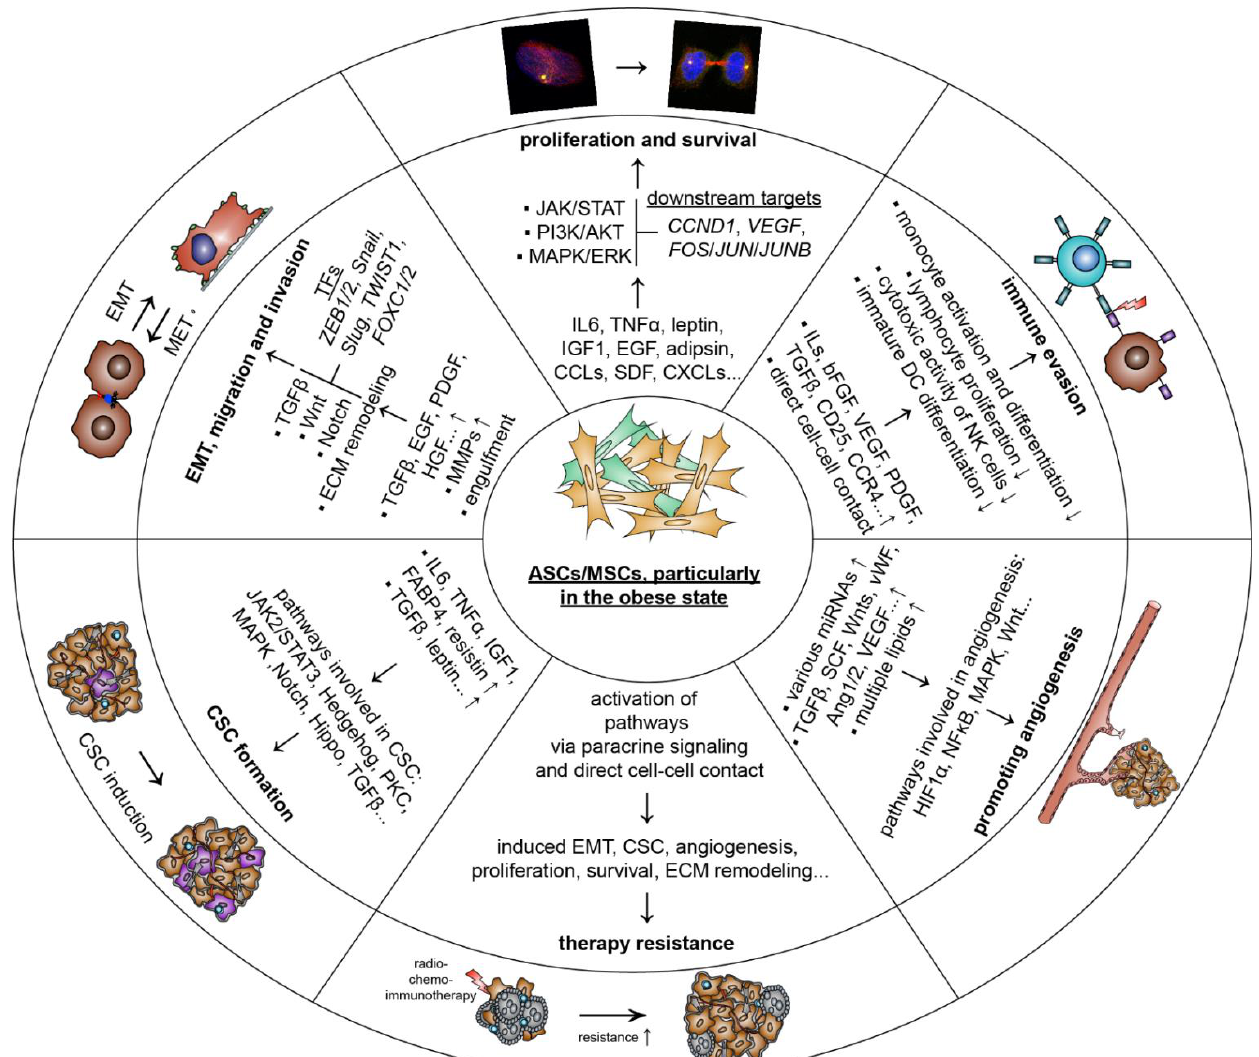
Figure 2. Schematic representation of potential effect of ASCs/MSCs on breast cancer cells and related molecular mechanisms. ASCs/MSCs may promote breast cancer cell proliferation and survival, EMT, migration, and invasion; CSC formation; angiogenesis; immune evasion; and therapy resistance. ASCs, adipose-tissue-derived mesenchymal stromal/stem cells; MSCs, mesenchymal stromal/stem cells; IL6, interleukin 6; EMT, epithelial-to-mesenchymal transition; STAT3, signal transducer and activator of transcription 3; ERK, extracellular-signal regulated kinase; IGF1, insulin-like growth factor 1; VEGF, vascular endothelial growth factor; MAPK, mitogen-activated protein kinase; AKT, protein kinase B; CCL2, monocyte chemotactic and activating factor; EGF, epithelial growth factor; PDGF-D, platelet-derived growth factor D; Wnt, wingless/integrated; TGF β , transforming growth factor β ; PI3K, phosphoinositide 3-kinase; CCR4, C-C motif chemokine receptor 4; TNF α , tumor necrosis factor α ; CD25, cluster of differentiation 25; SNAI, snail family transcriptional repressor; ZEB1, zinc finger E-box binding homebox 1; CAF, cancer-associated fibroblast; CSC, cancer stem cell; JAK2, Janus kinase 2; FABP4, fatty acid binding protein 4; PKC, protein kinase C; HGF, hepatocyte growth factor; MMP, matrix metalloprotease; bFGF, basic fibroblast growth factor; vWF, von-Willebrand